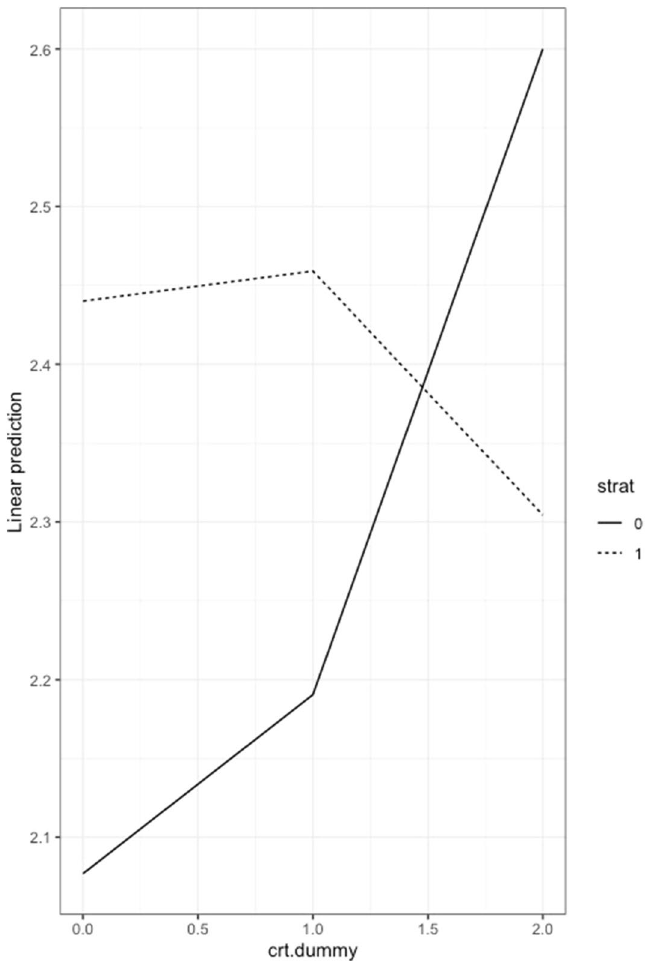
Figure 4. Interaction-style plot for estimated marginal